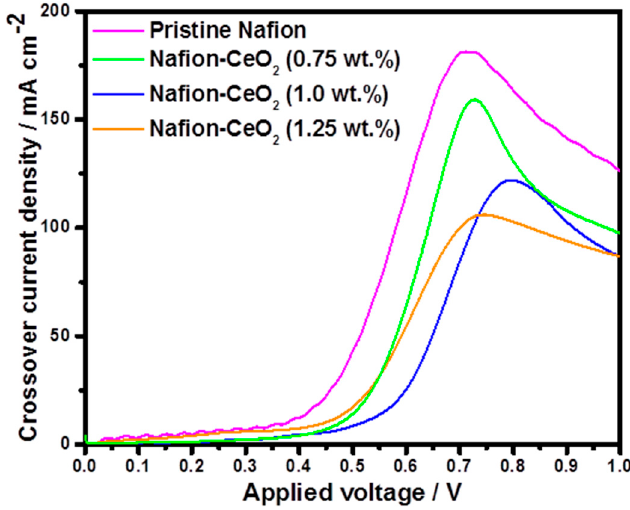
Figure 6. Methanol crossover current densities of pristine Nafion and Nafion-CeO 2 composite membranes at room temperature.